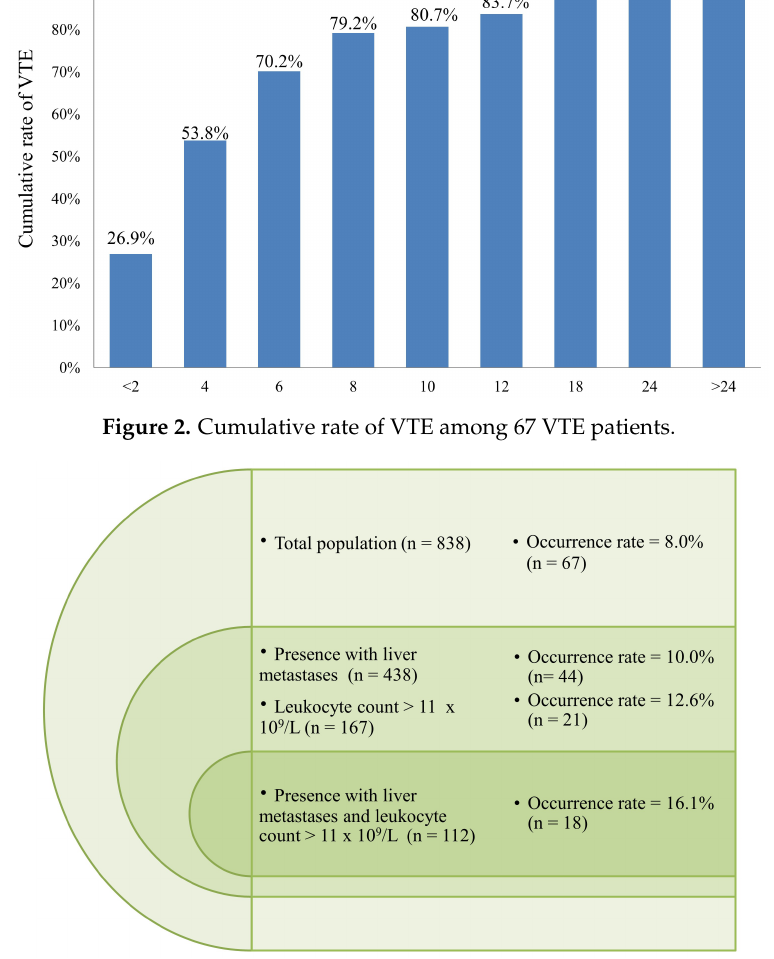
Figure 3. Distribution of VTE according to the risk factors presented by patients.